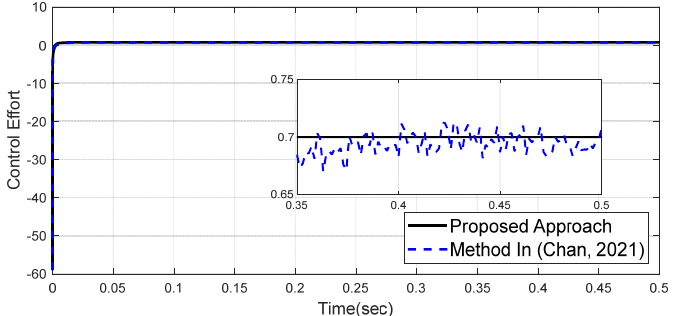
Figure 4. Controller effort signals [1] .